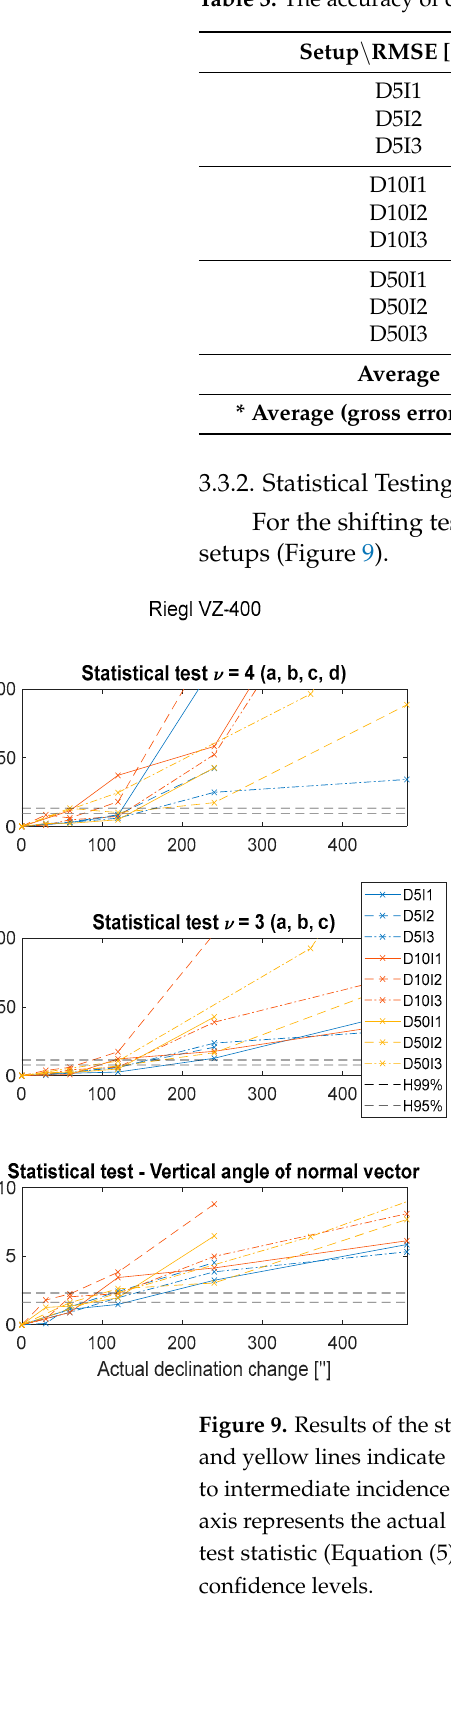
Table 3. The accuracy of detected tilting declinations: RMSE values.